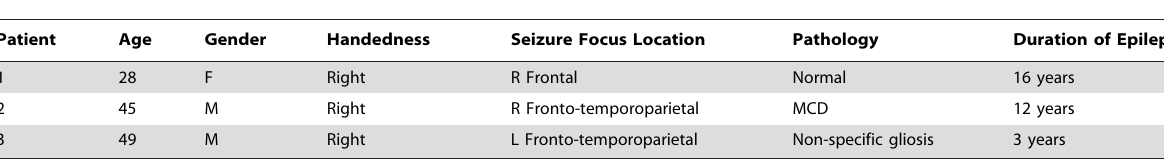
Table 1. Patient Demographics & Clinical Information.